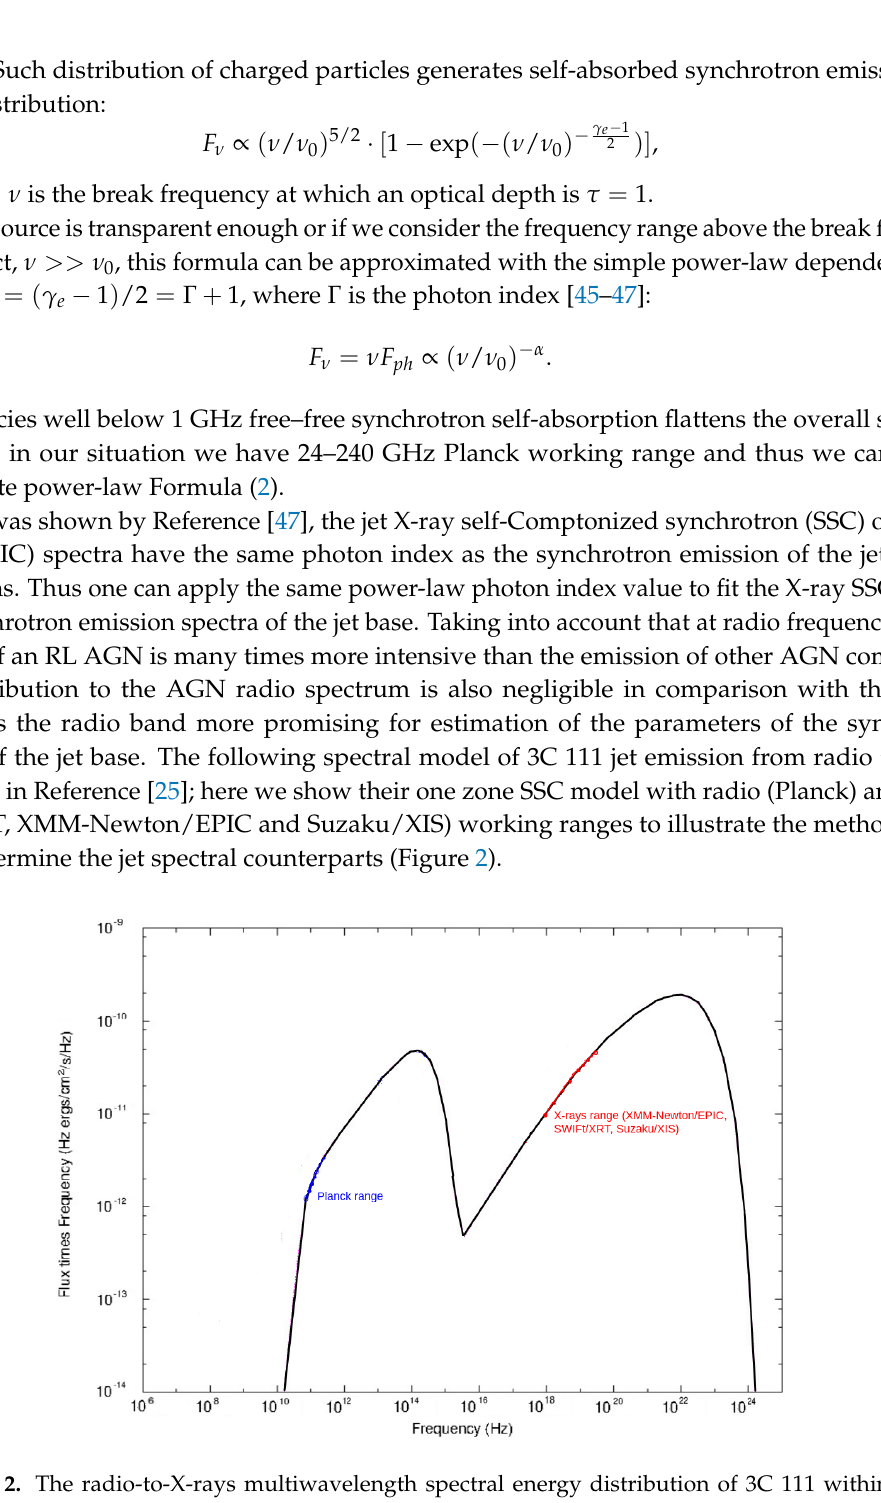
Figure 2. The radio-to-X-rays multiwavelength spectral energy distribution of 3C 111 within the one-zone SSC model [25], shown by black solid line. The frequency range of Planck is shown by blue zone and X-rays range corresponding to Swift/XRT, XMM-Newton/EPIC and Suzaku/XIS is shown by